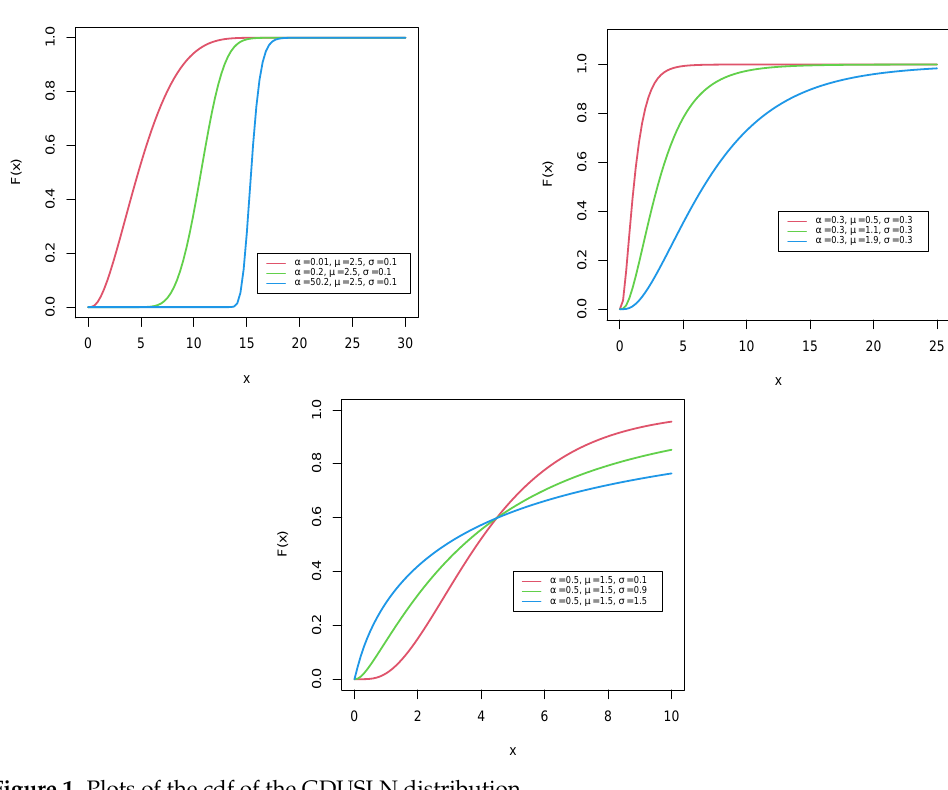
Figure 1. Plots of the cdf of the GDUSLN distribution.